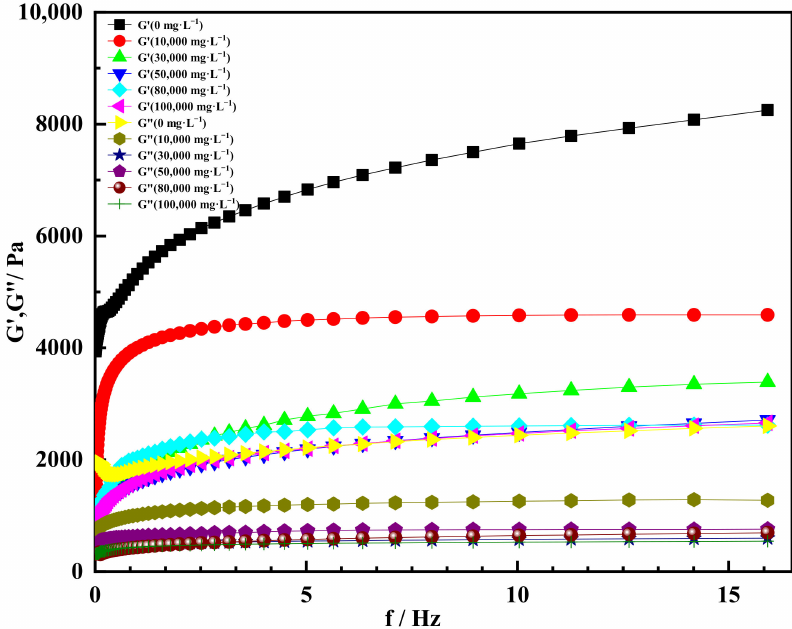
Figure 13. Storage modulus and loss modulus varied with scanning frequency at different concentra- tions of univalent salt ions.